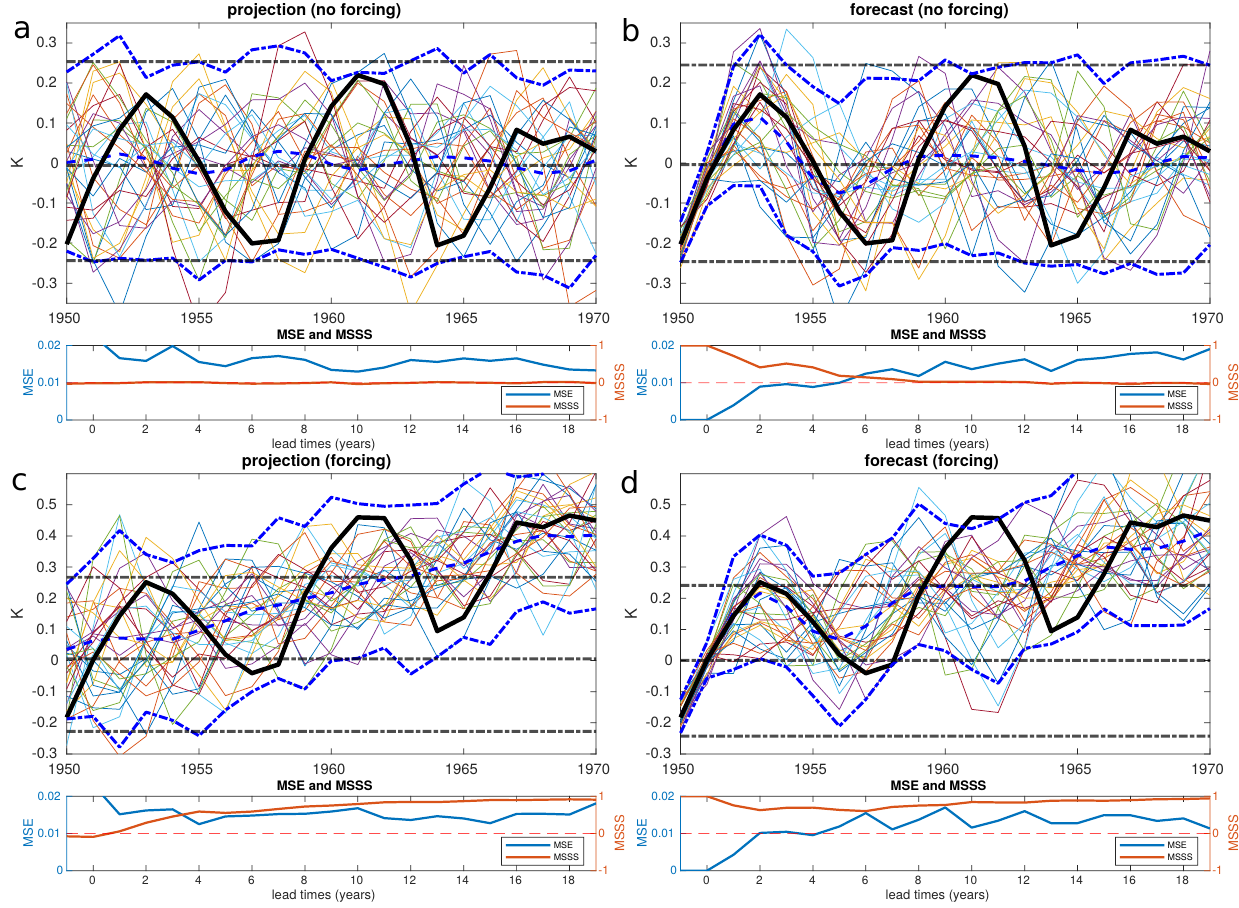
Figure 5. Experiments without and with initial conditions and forcing. The four cases correspond to experiments with ( a ) no initial conditions and no forcing, ( b ) initial conditions and no forcing, ( c ) no initial conditions and forcing, and ( d ) both initial conditions and forcing. In part ( a ), top panel, the colored lines show a set of 30 idealised climate projections, nominally starting in 1950. The solid black line is the member taken to represent the ‘observations’. The horizontal dashed black lines represent the 2.5, 50, and 97.5 percentile values of the climatological distribution of ‘observations’ calculated from the long control run of the model. The dashed blue lines are the values of the 2.5 percentile, ensemble mean, and 97.5 percentile from the distribution of 100 projection members, calculated each year to show their variation in time. In part ( a ), the bottom panel shows the MSE and MSSS skill scores from this experiment as a function of lead time. The skill scores are calculated over the 150 forecasts in each experiment. In part ( b ), the colored lines are a set of 30 forecast members without forcing. The solid and dashed lines are defined as in part a. In part ( c ), top panel, the colored lines are a set of 30 projection members with forcing. The observations are represented by the black line, which has the same linear forcing term as the projection members. In part ( d ), top panel, the colored lines are 30 forecast members with forcing. The same linear forcing has been applied to the forecast members and the observed member (black